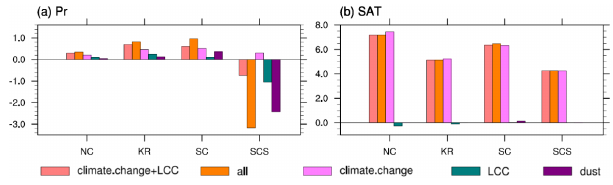
Figure 10. Future changes in precipitation (mmday − 1 ) (a) and sur- face air temperature (K) (b) over the box regions of North China (NC), Korea (KR), south China (SC) and the South China Sea (SCS) in summer. Note that “all” means sum of climate change, land cover change and direct radiative effect of dust; “LCC” and “Dust” are “double differences”, illustrating the influence of those processes on the future–present